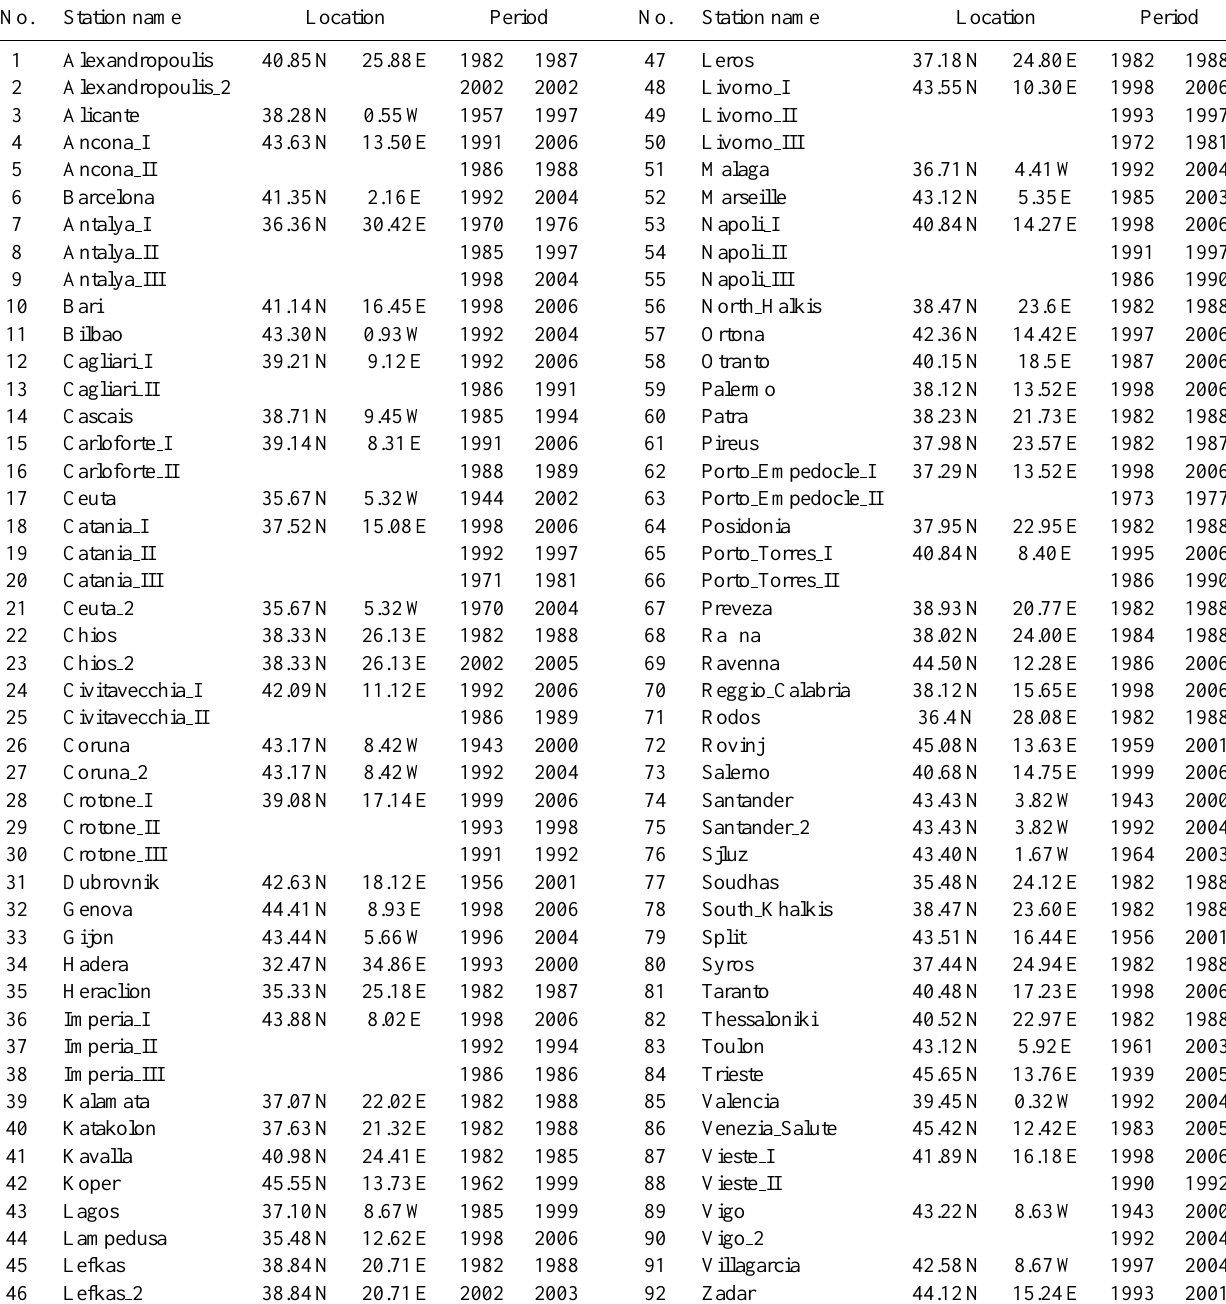
Table 1. The geographical coordinates and the period of operation of the tide gauge stations used in this study. Some tide gauge records were split (i.e. named as I, II, etc.) due to inconsistencies in their mean sea level indicating benchmark shifts (see Marcos et al.,